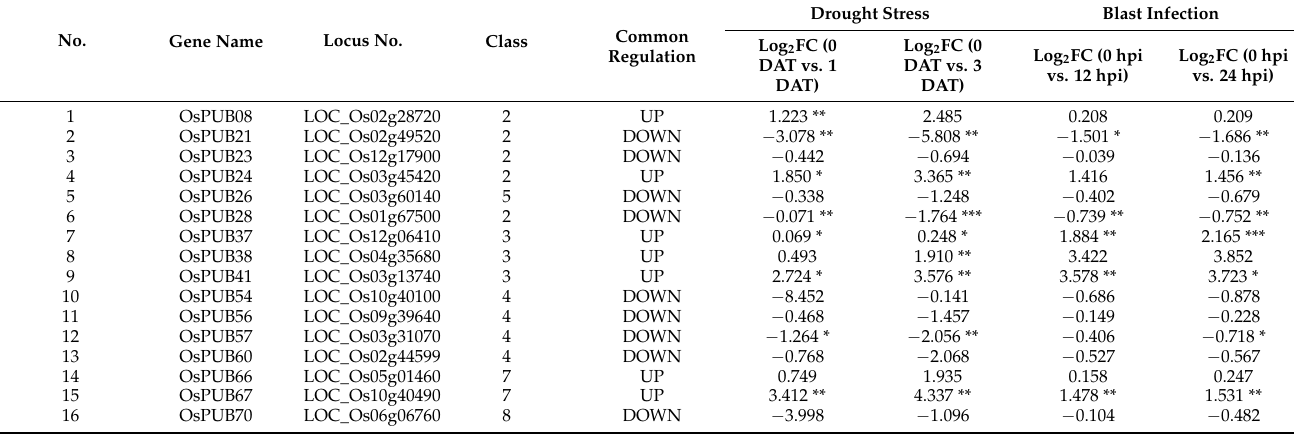
Table 1. A list of OsPUB genes showing the same expression pattern under abiotic stress (drought condition) and biotic stress (blast